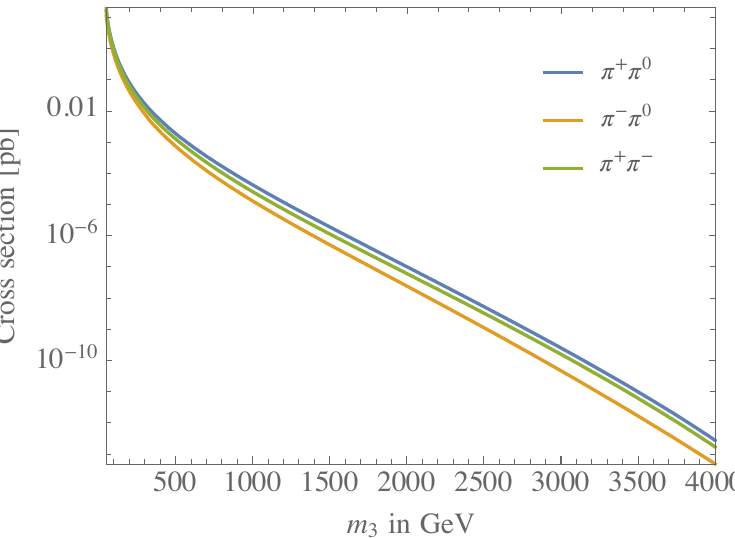
Figure 4 . Leading-order cross section for π + π 0 (blue), π − π 0 (orange) and π + π − (green) pair production at the 13 TeV LHC, where π ± , 0 denotes any of the NGB triplets with electromagnetic charge indicated by the superscript.